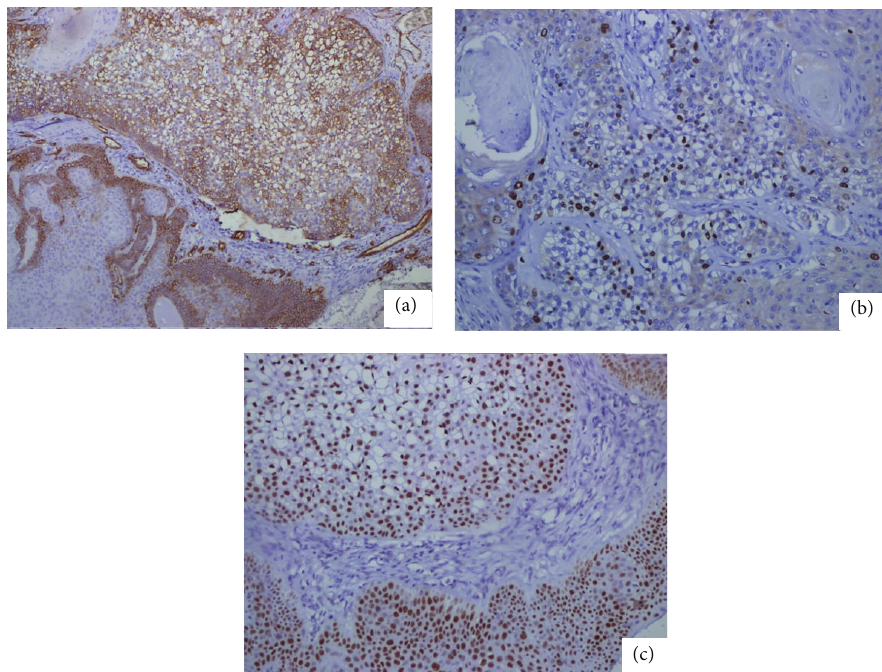
Figure 2: Immunochemical study of the malignant proliferating trichilemmal tumor. Focal CD34 staining is remarkably observed in the cells with translucent cytoplasm and basaloid fields (DAP, × 100) (a). Nuclear Ki-67 staining is remarkably observed in the tumor cells with translucent cytoplasm (DAP, × 200) (b). A diffused and strong staining with P53 is observed (DAP, × 200)